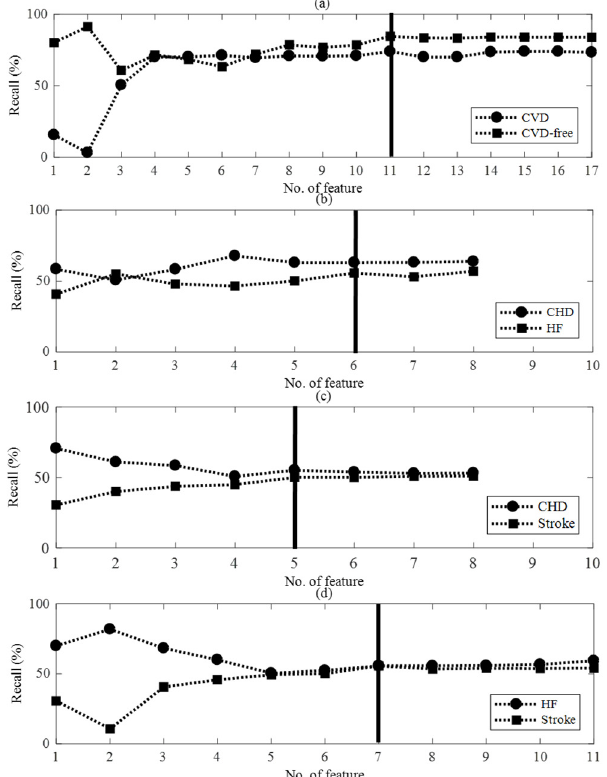
Figure 4. The classification performance according to number of features for feature selection. ( a ) CVD and CVD-free, ( b ) CHD and HF, ( c ) CHD and stroke, and ( d ) HF and stroke. Table 1. The prediction results of incident CVD outcomes for the training set. Actual CVD-Free CHD HF Stroke Predicted